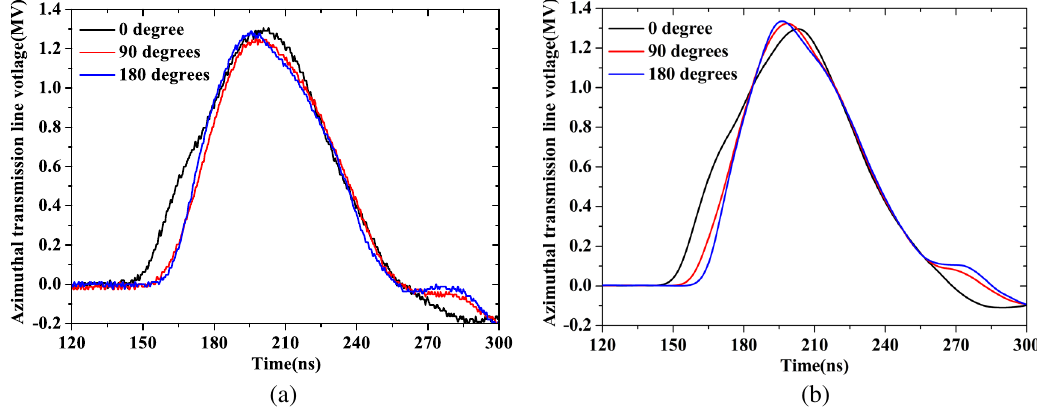
and L denote the resistance and load load